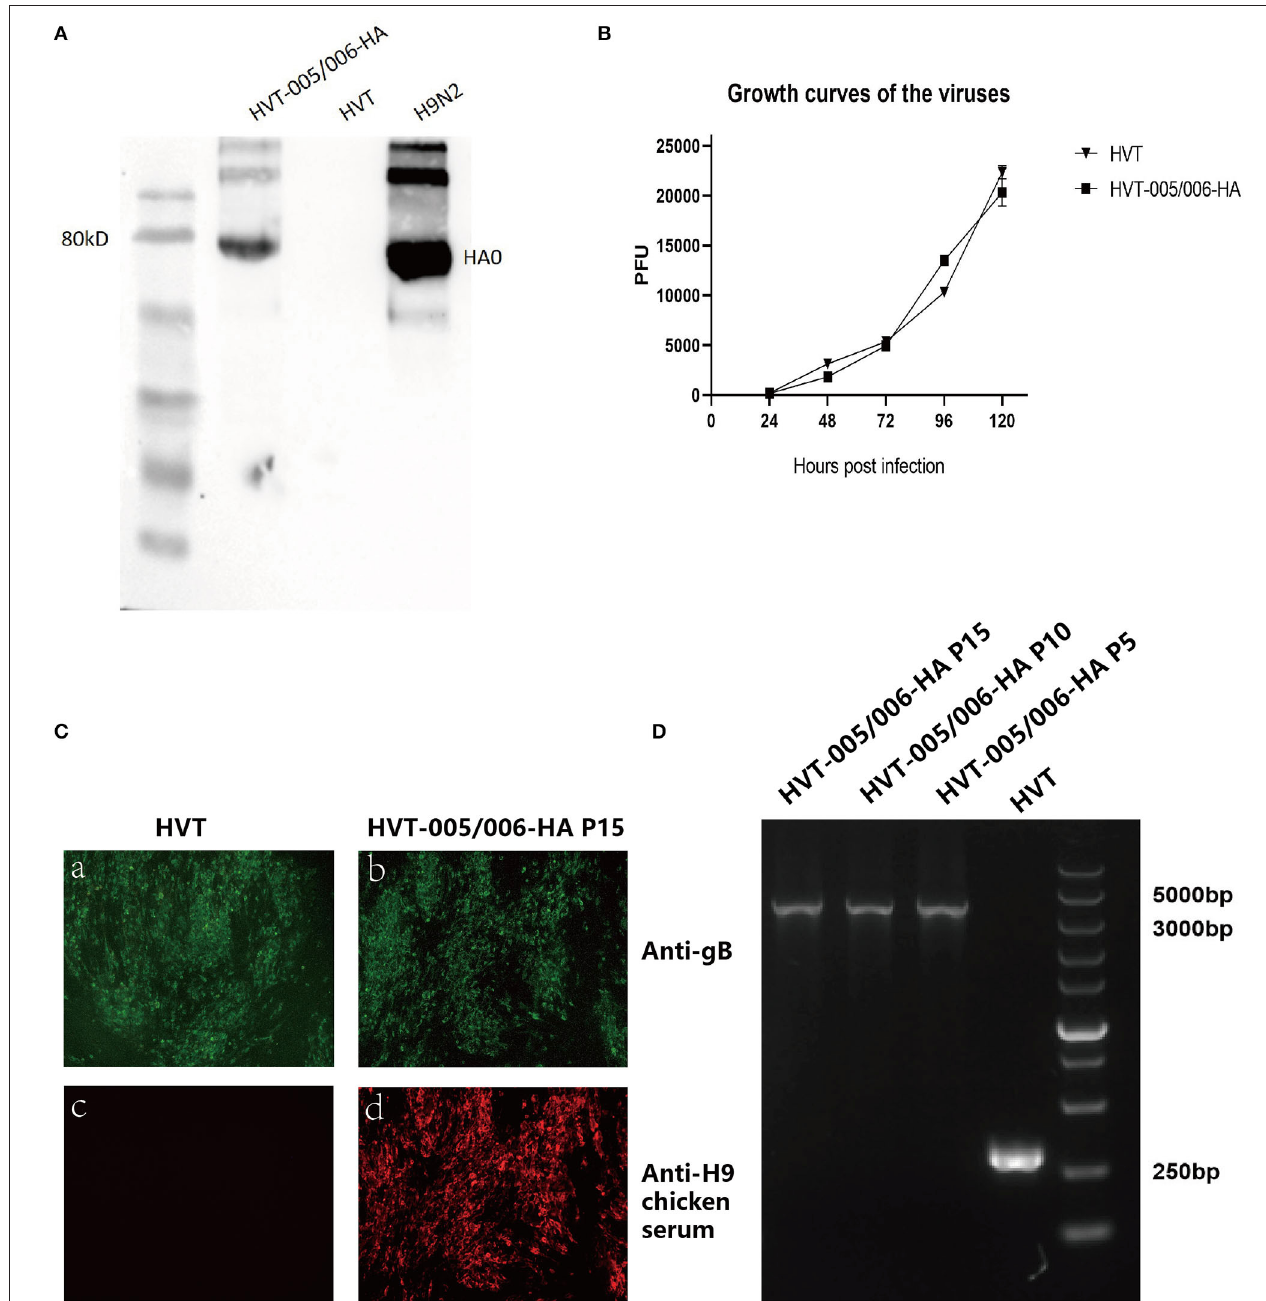
FIGURE 3 | Characterization of recombinant HVT-005/006-HA. (A) Detection of HA expression by Western blot. (B) Growth curves of HVT-005/006-HA and HVT. HVT-005/006-HA and HVT viruses were inoculated into CEFs seeded in 12-well plates with 100 PFU per well. Cells were harvested and titrated at 24, 48, 72, 96, and 120h post-infection. (C) Detection of HA expression from HVT-005/006-HA at passage 15 in CEFs by IFA using anti-H9 chicken serum. HVT infection was confirmed by immunostaining with anti-gB monoclonal antibody BD8. IFA for CEFs infected with HVT using anti-gB monoclonal antibody BD8 (a) . IFA for CEFs infected with HVT-005/006-HA P15 using anti-gB monoclonal antibody BD8 (b) . IFA for CEFs infected with HVT using anti-H9 chicken serum (c) . IFA for CEFs infected with HVT-005/006-HA P15 using anti-H9 chicken serum (d) . (D) PCR analysis to confirm the presence of HA expression cassette from HVT-005/006-HA at passages 5, 10, and 15 in CEFs using primer pair outside of the insertion